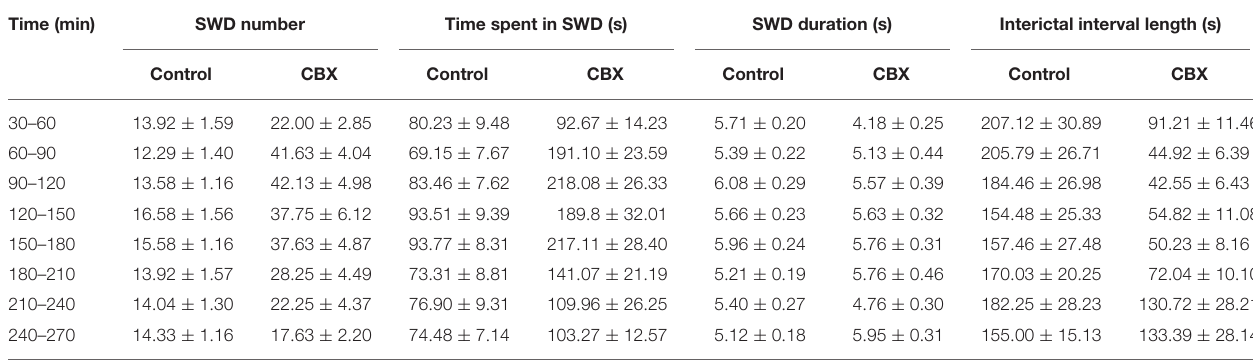
TABLE 2 | Synchronous spike-wave discharge (SWD) parameters in WAG/Rij rats ( n = 8) in control conditions and after i.c.v. administration of 100 mg/kg carbenoxolone (CBX). Time (min)